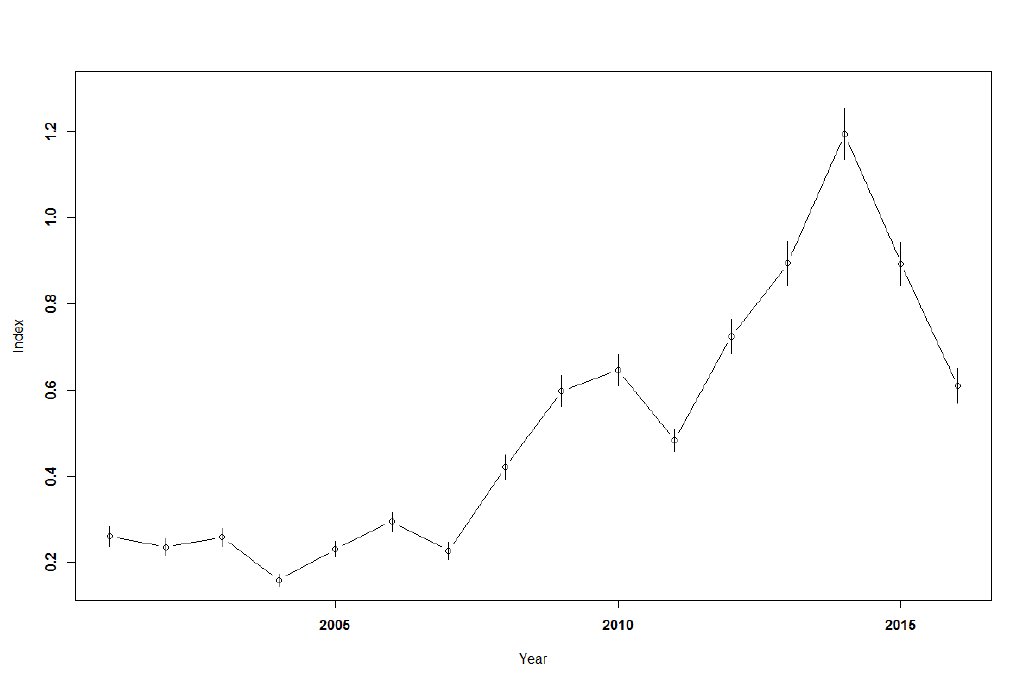
Figure 64. Index of relative abundance of horseshoe crab (delta mean catch per tow) developed from the spring portion of North Carolina’s Estuarine Gill Net Survey with 95% confidence intervals.